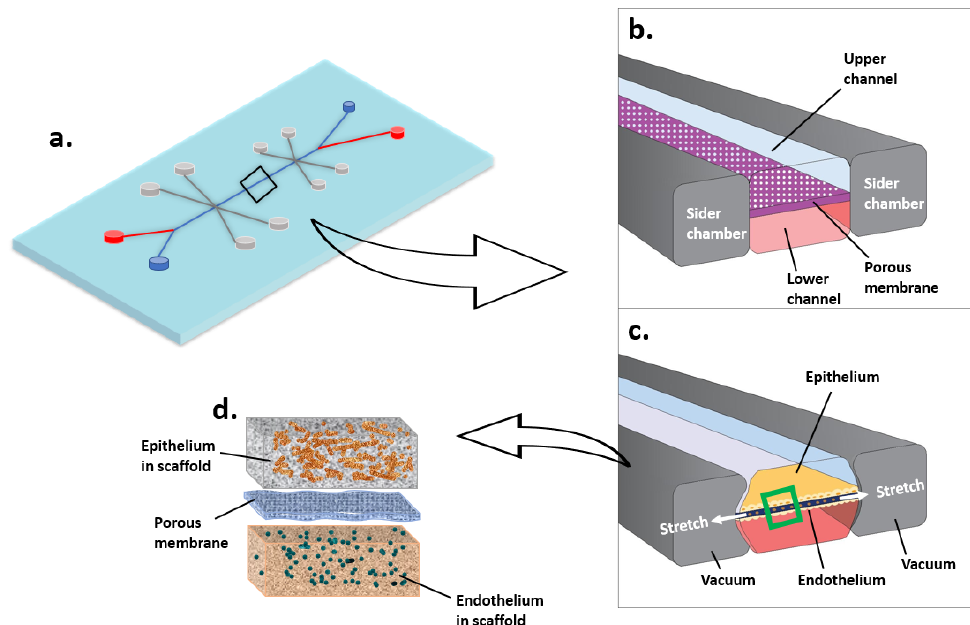
Figure 3. Microfluidic cell culture system (Organ-on-a-chip, taking lung as an example). ( a ) Lung on a chip. ( b ) The air flows through the upper channel. The blood flows through the lower channel. ( c , d ) Epithelium and endothelium grow in scaffolds on each side of the porous membrane. The stretch of membrane mimics lung breathing.